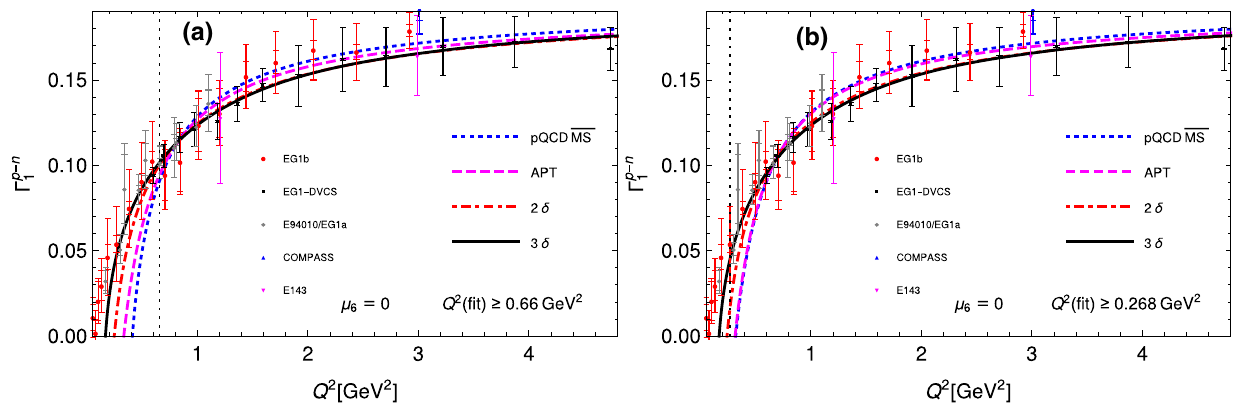
Q 2 ≥ 0 . 268 GeV 2 . See the text for details. The respective lower bound − n = 0 . 66 or 0 . 268 GeV 2 , is included as the ( Q 2 ) of the fitting interval, Q 2 inel . , in four min 1 thin dotted vertical